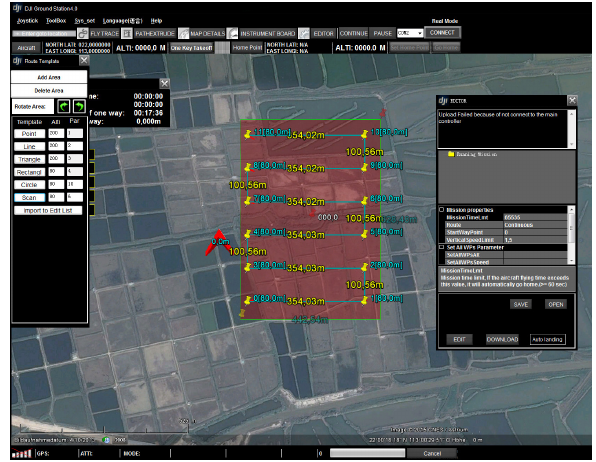
Figure 7: Mission Planning with the DJI PC Ground